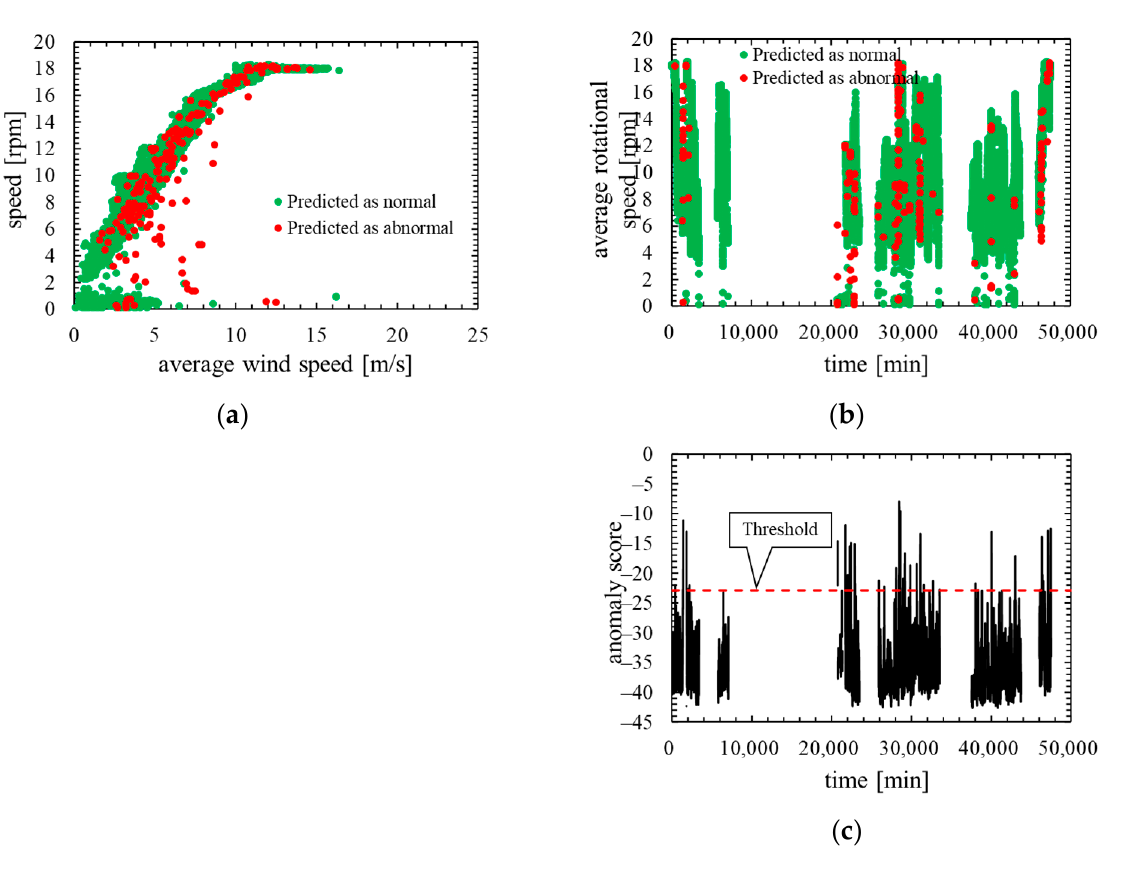
Figure 7. Training data of the model in which the number of mixture components K was determined based on BIC ( K = 29, the threshold is the 99th percentile’s value): ( a ) wind speed rotational speed characteristic; ( b ) time characteristics of rotational speed; ( c ) time characteristics of anomaly score.